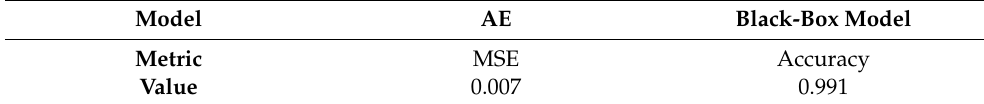
Table 1. Results obtained for the AE in terms of MSE and for the black-box model in terms of accuracy.